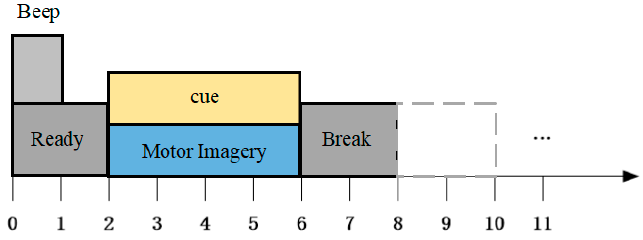
Figure 3. The training data acquisition experiment procedure of a real-time BCI system.